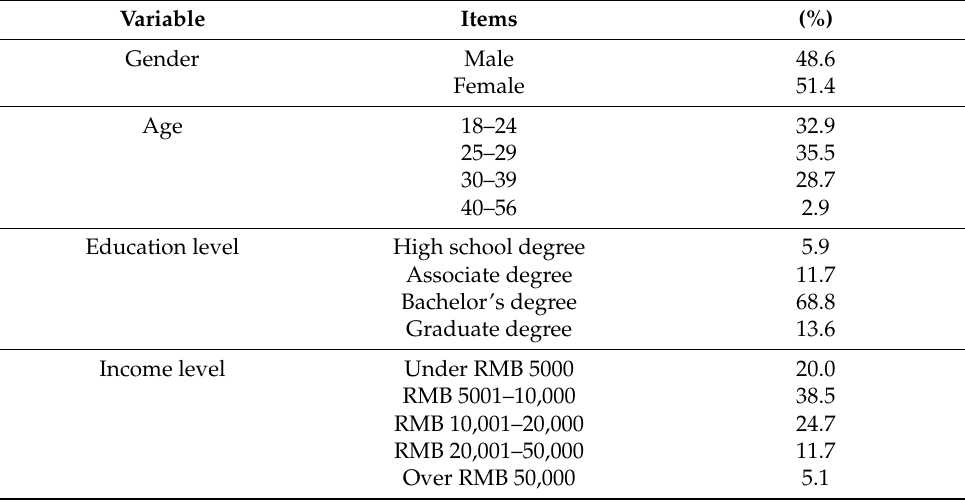
Table 1. Demographic profile of the sample ( n =